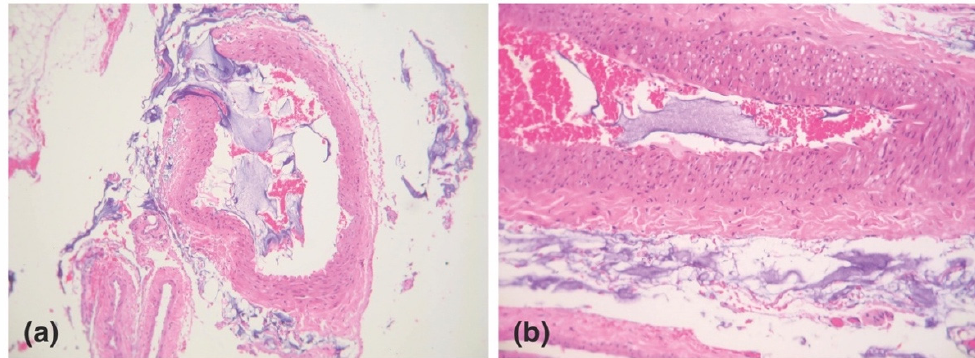
Figure 17. Histopathology of a hyaluronic acid (HA) filler-inoculated rat femoral artery demonstrat- ing the thrombogenicity of HA gels. ( a , b ) Photomicrographs of hematoxylin and eosin (H&E) stained femoral artery sections at the site of arterial cannulation ( a ) and distally ( b ), showing the presence of intravascular thrombi associated with basophilic HA filler material, respectively; from Baley-Spindel et al. [175], with permission.